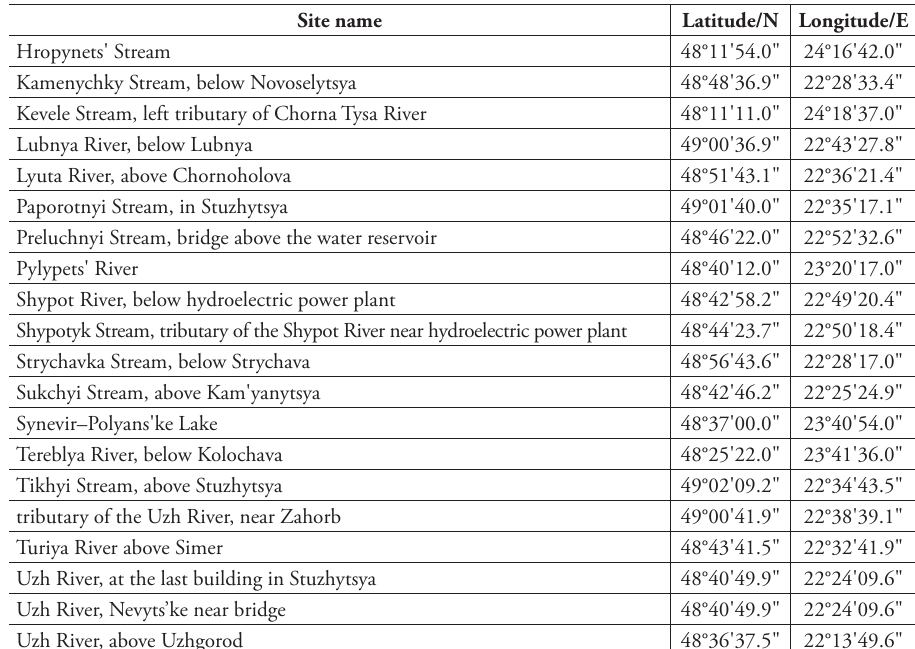
Table 1. List of collecting